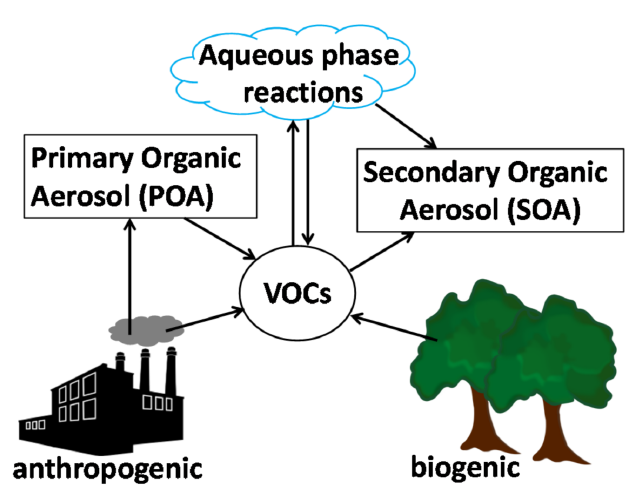
Figure 1. Pictorial representation showing formation pathways of secondary organic aerosol (SOA) species in the atmosphere from volatile organic compounds